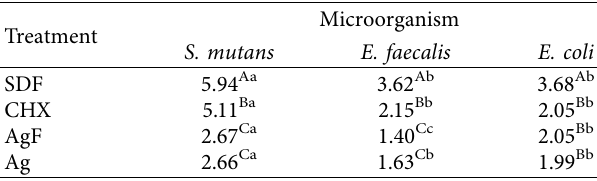
Medians followed by distinct letters (lowercase letters in row; up- percase letters in columns) are significantly different by Dunn’s test ( p < 0.05).